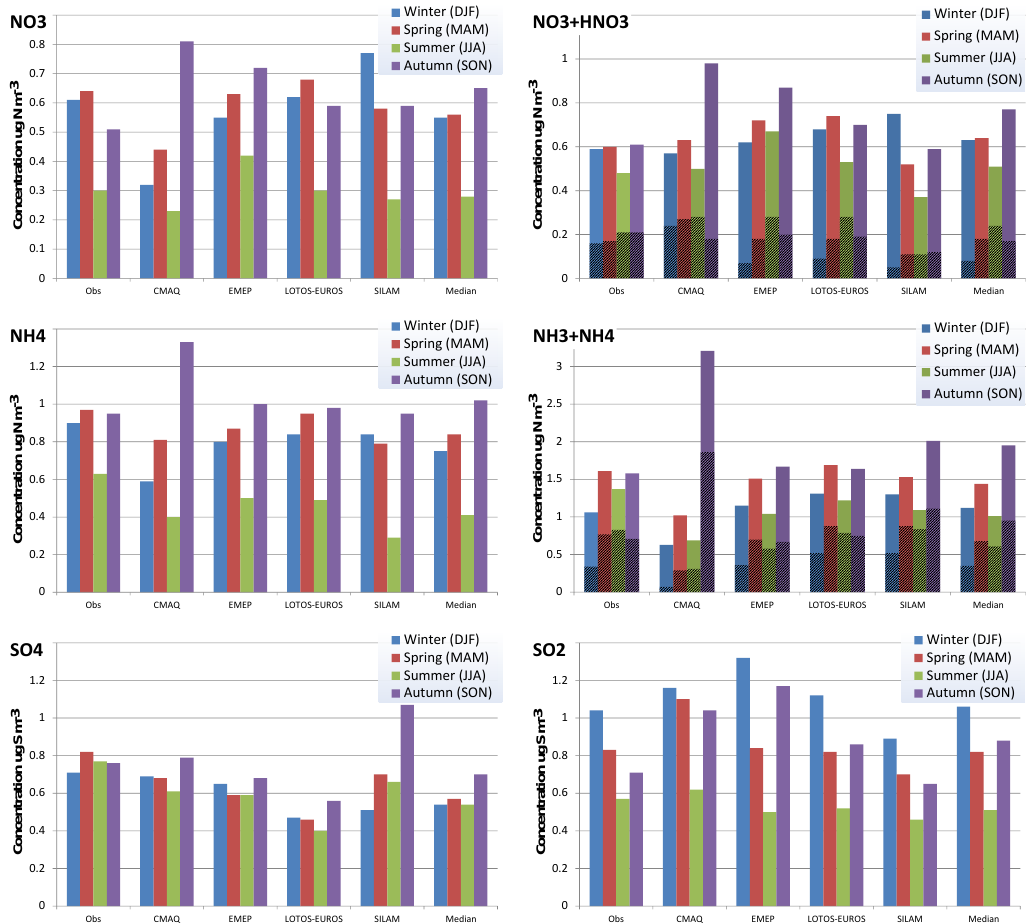
Figure 4. Observed and predicted seasonal concentrations of secondary inorganic aerosols and their precursors, mean over the EMEP stations (µgS/Nm − 3 ). Shaded part shows the concentration of the gas phase species HNO 3 and NH 3 . Only the stations where at least two of the gas, aerosol and their sum were observed, so that the gas phase fraction could be estimated, are included in the averaging.